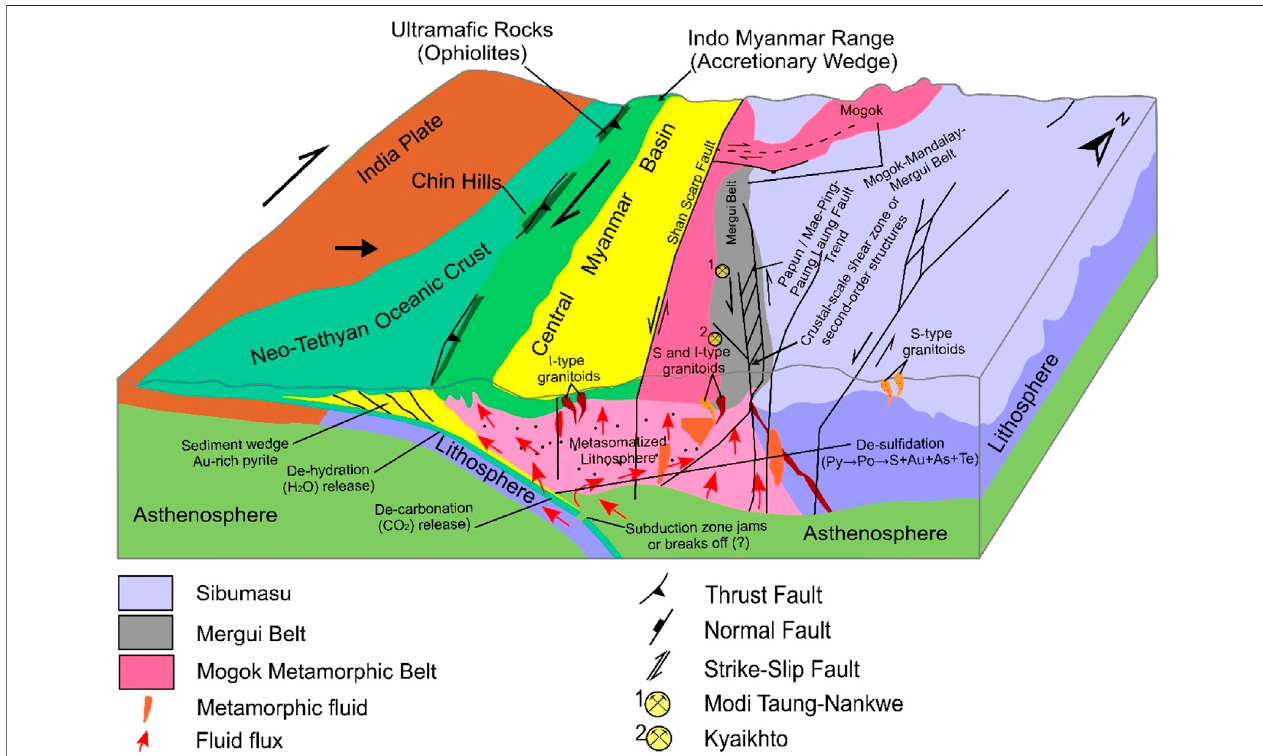
FIGURE 16 | Tectonic setting of Myanmar during Lower Cretaceous to Oligocene depicting formation and evolution of gold mineralization in the framework of subduction andcollision-based modelforore- fl uidsource(s)oftheorogenicgold depositsofMergui Belt(Modi fi edafter Gardineret al.,2016, 2018;Groves et al.,2019,